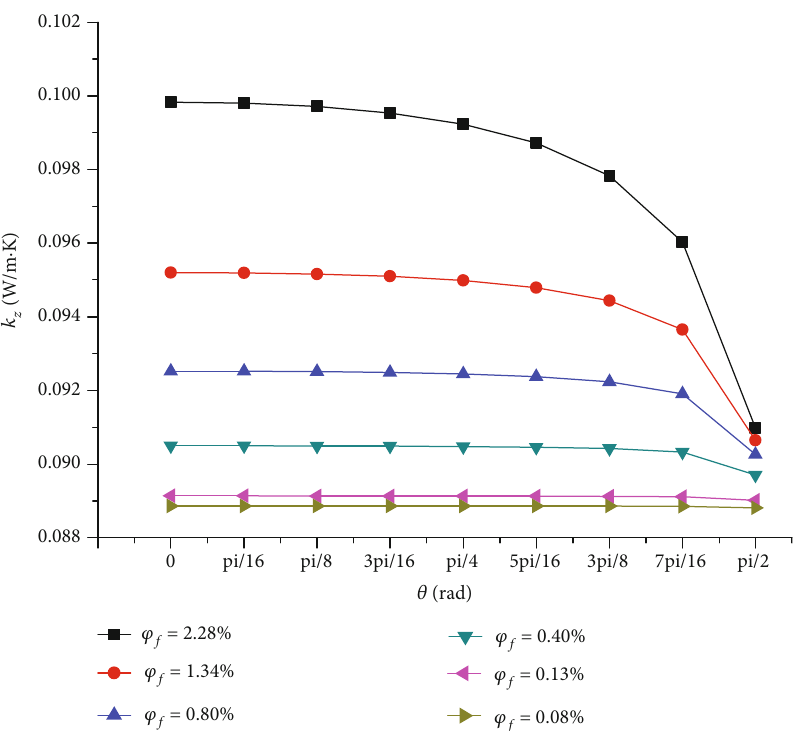
Figure 25: E ff ect of fi ber volume fraction and orientation angle on thermal conductivity.